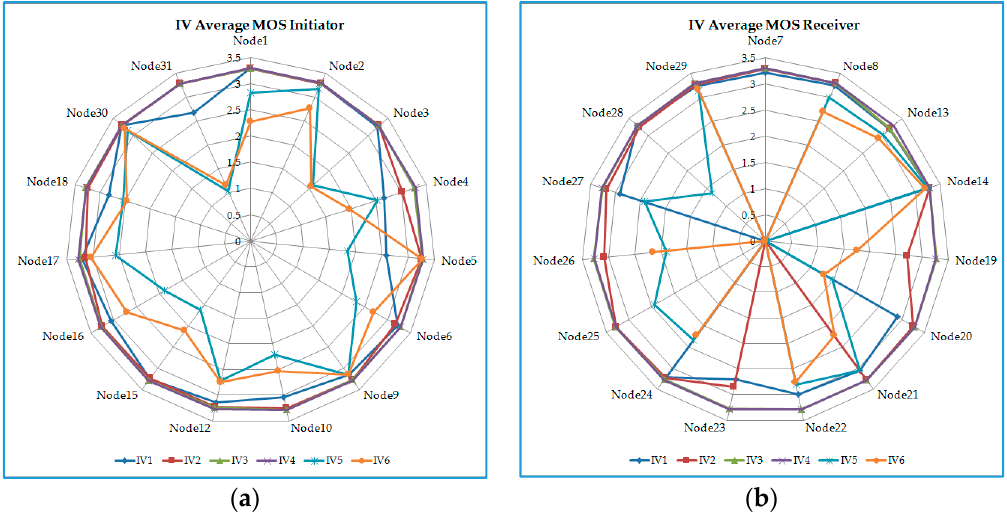
Figure 12. Isolated village MOS values for VoIP initiators: ( a ) VoIP initiators; ( b ) VoIP receivers.